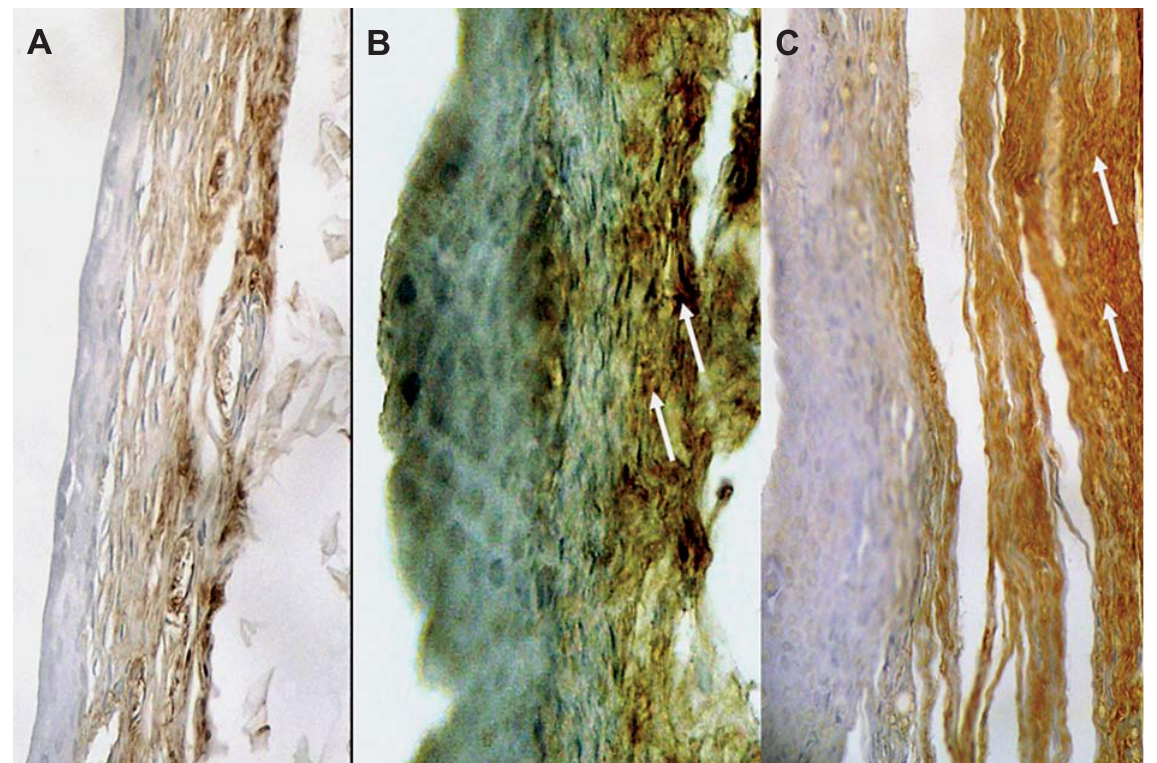
Figure 4 – Changes in alpha-actin expression over time. A) Muscle layer of non-grafted area. B) Hyperplasia of smooth muscle cells growing into the latex biomembrane 45 days after surgery; note the high expression of alpha-actin (stained in brown - white arrows). C) Reduction of alpha-actin-positive expression and muscular cells with a lesser degree of hyperplasia 3 months after surgery.